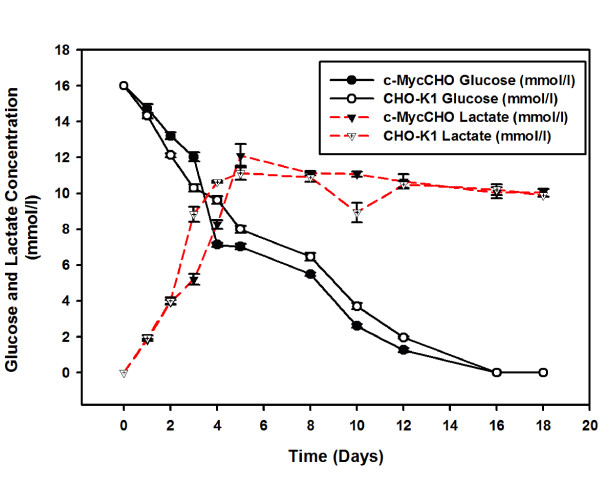
Glucose utilization and lactate production. For the cMycCHO culture, glucose utilisation is represented by a solid line with a black circle and a solid line with clear circle for CHO-K1. For lactate measurements, taken from the extracellular environment, the cMycCHO culture is represented by a dashed line with black upside down triangles and CHO-K1 is indicated with a dashed line with clear upside down triangles. Both cultures show a similar profile but differ in specific utilisation and production.